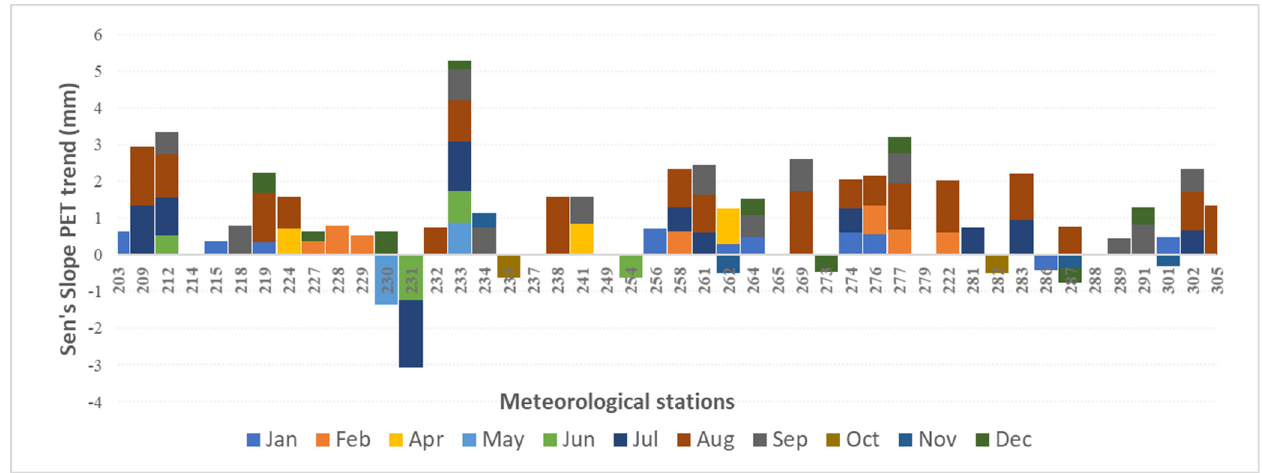
Figure 5. The monthly trend Sen’s slope magnitude of PET in mm in all analysed meteorological stations.